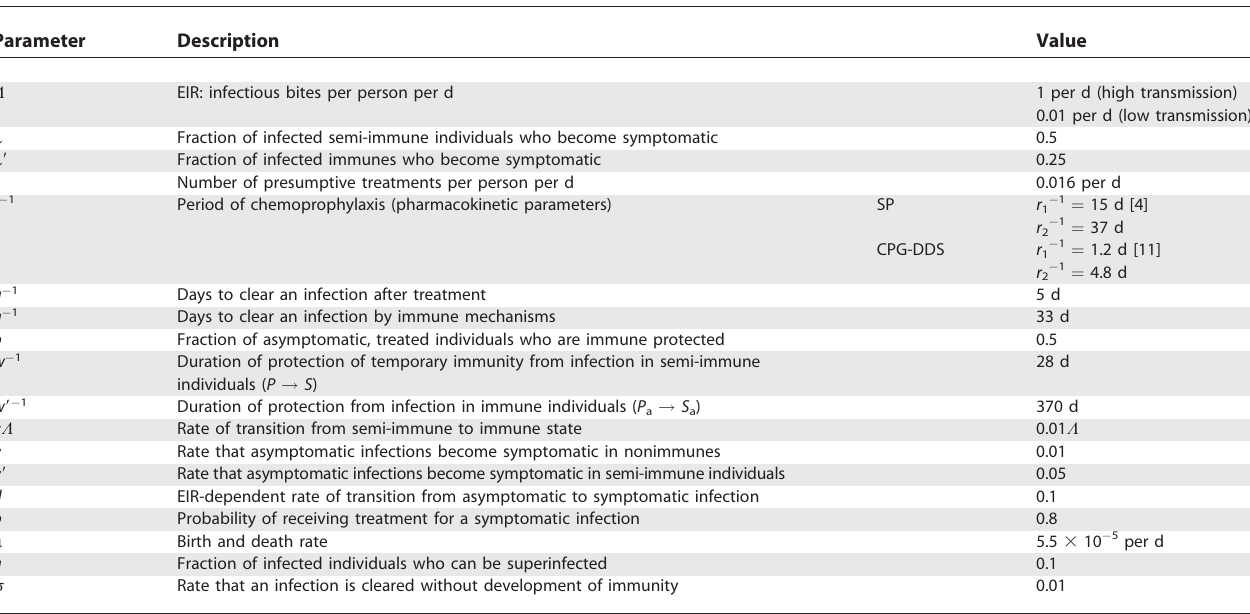
Table 2. Parameters, Definitions, and